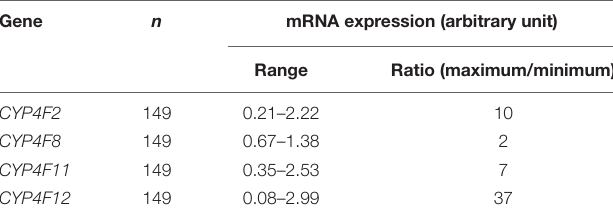
TABLE 1 | Variability of mRNA expression in the CYP4F gene